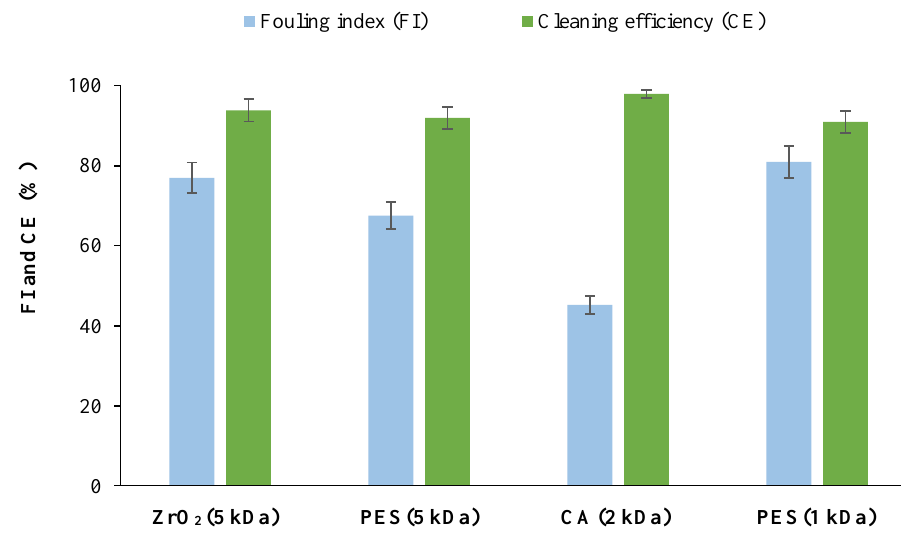
Figure 7. Fouling index and cleaning efficiency after the filtration with all the tested membranes.